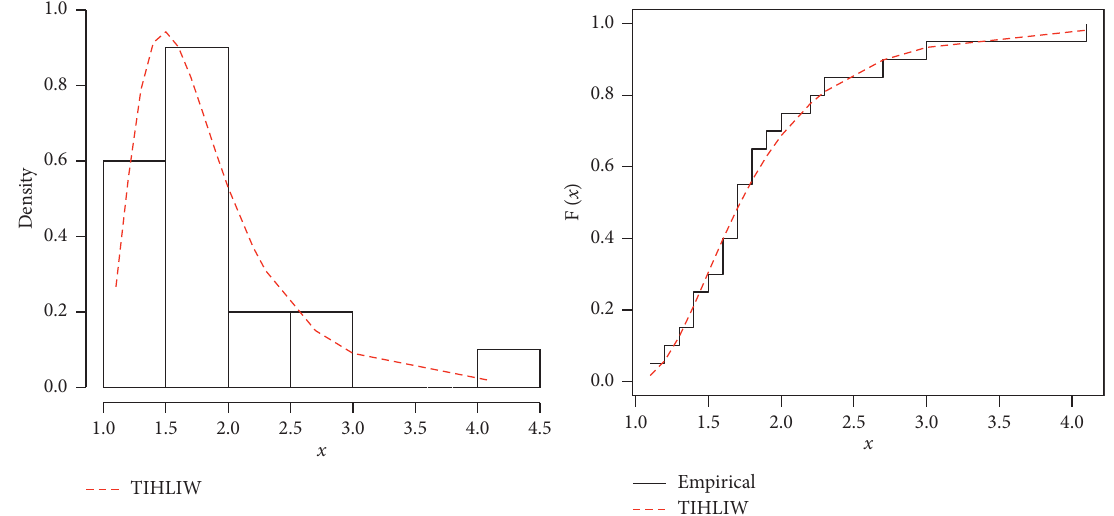
Figure 2: The fitted PDF and estimated CDF of the TIHLIW